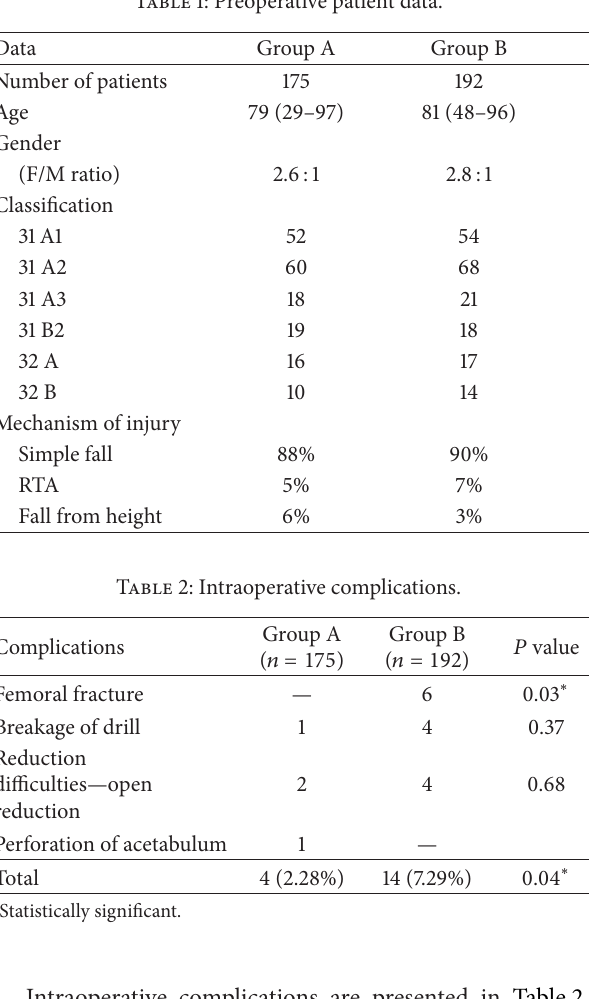
Table 1: Preoperative patient data.